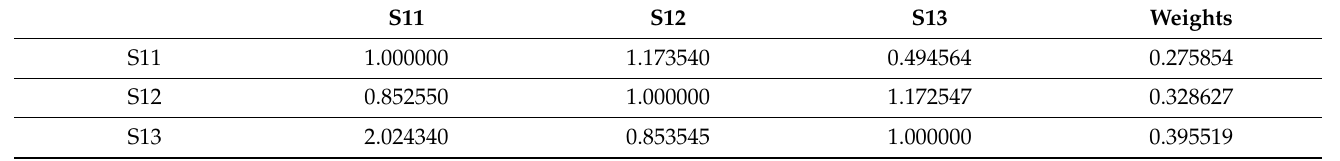
Table 7. The aggregated pairwise comparison matrix at Level 2 for regulatory.